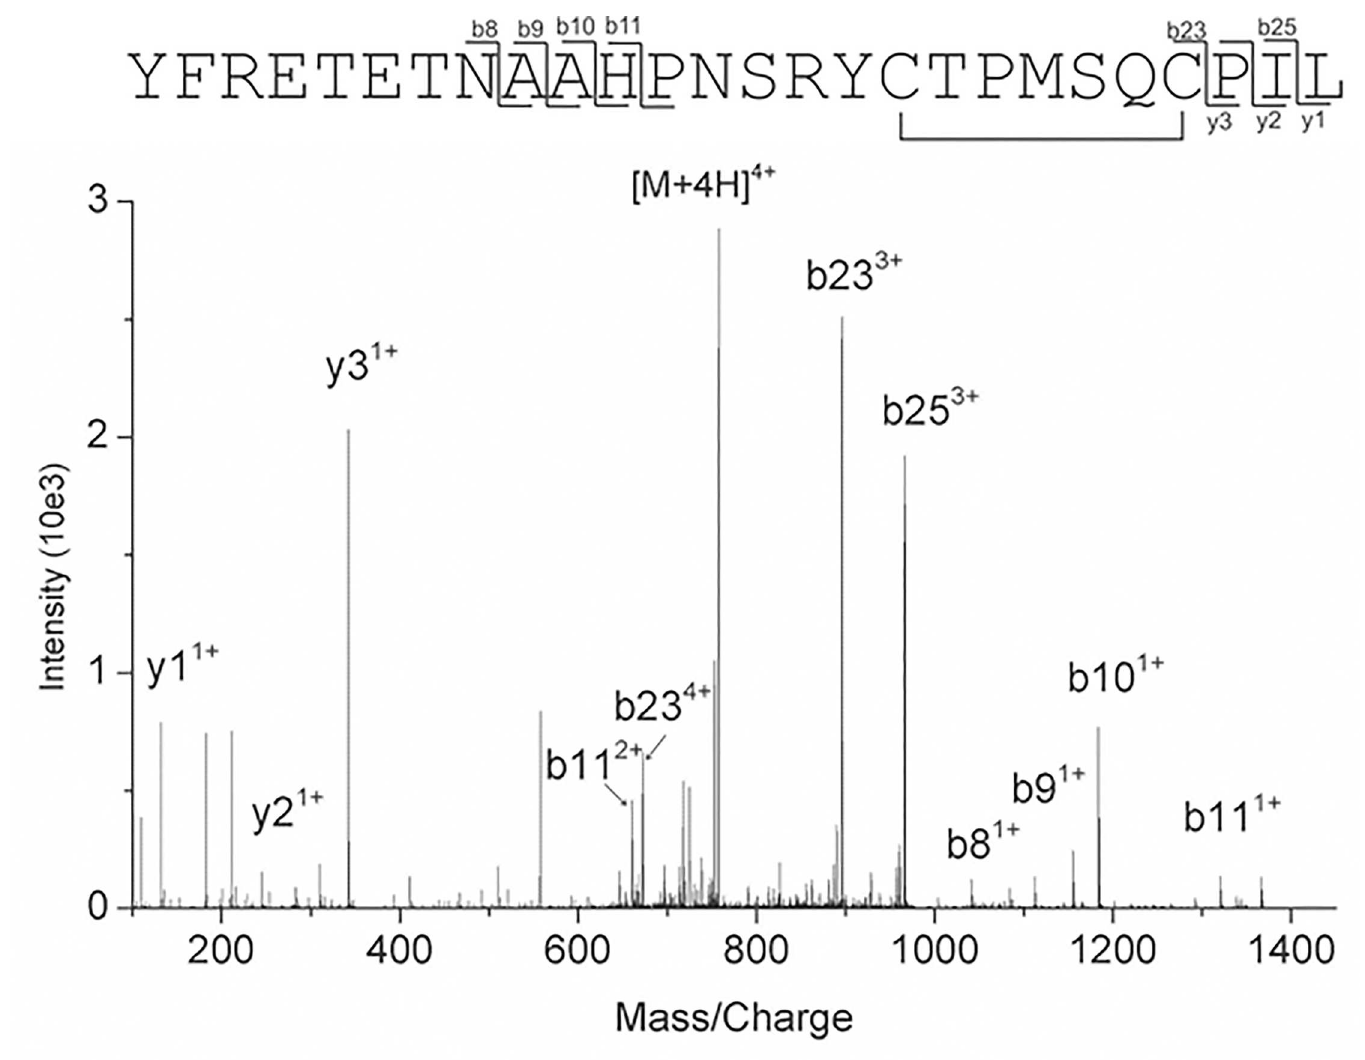
Fig 2. MS/MS spectrum of ion m/z 757.6. The experimental fragment ions correspond to the theoretical fragmentation of peptide YFRETETNAAHPNSRYCTPMSQCPIL with the cysteines C391 and C397 in the form of disulfidebridge. Most intensefragments visible in the spectrum are annotated by specific fragmentation series, number of the fragment in the series and the chargeof the ion (in exponent). The same fragments are also visualizedin the peptidesequenceon top of the spectrum. For details of the fragmentation, see the S1